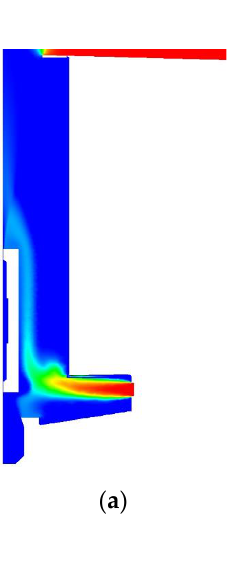
Figure 17. Temperature in the burner and at its outlet, °C: ( a ) 1 reaction EDC; ( b ) 60 reactions EDC; ( c ) 305 reactions EDC.